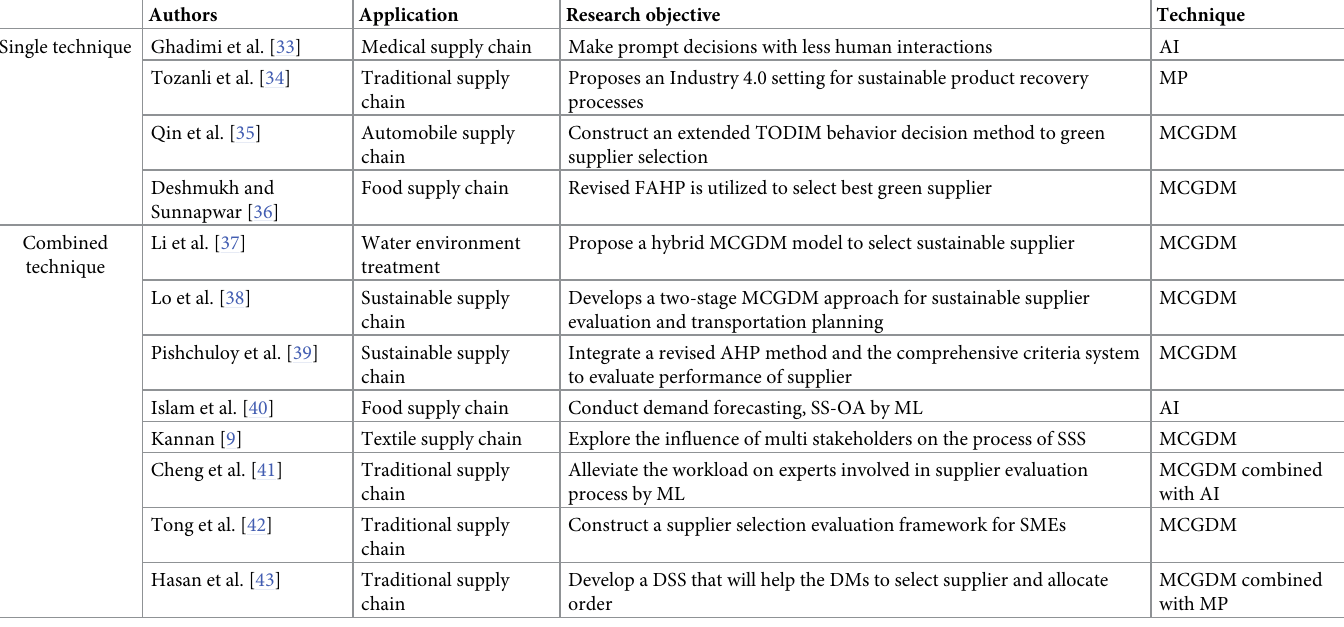
Table 1. A summary of representative studies on supplier selection and order